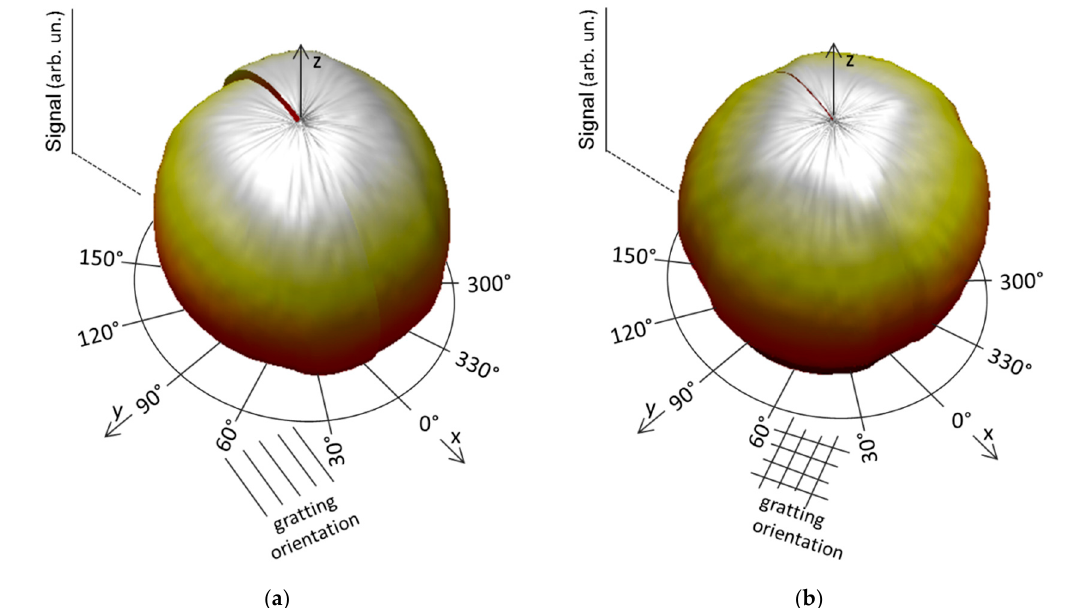
Figure 5. ( a ) 3D radiation pattern of 1D PhC LED and ( b ) 2D PhC LED with the same period of 700 nm.